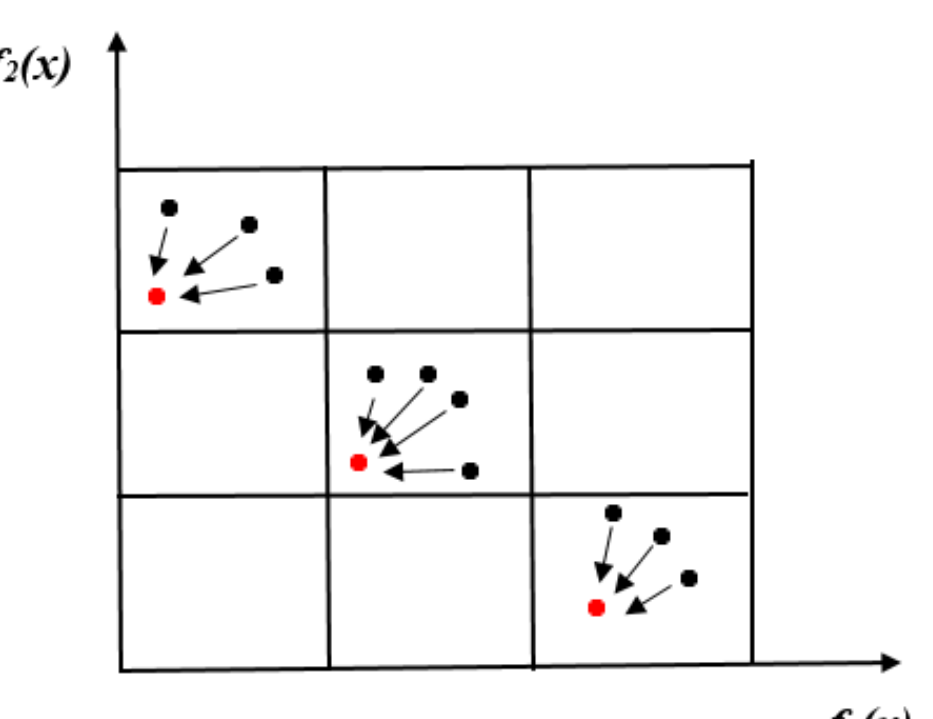
Figure 2. Adaptive grid-based mutation strategy .